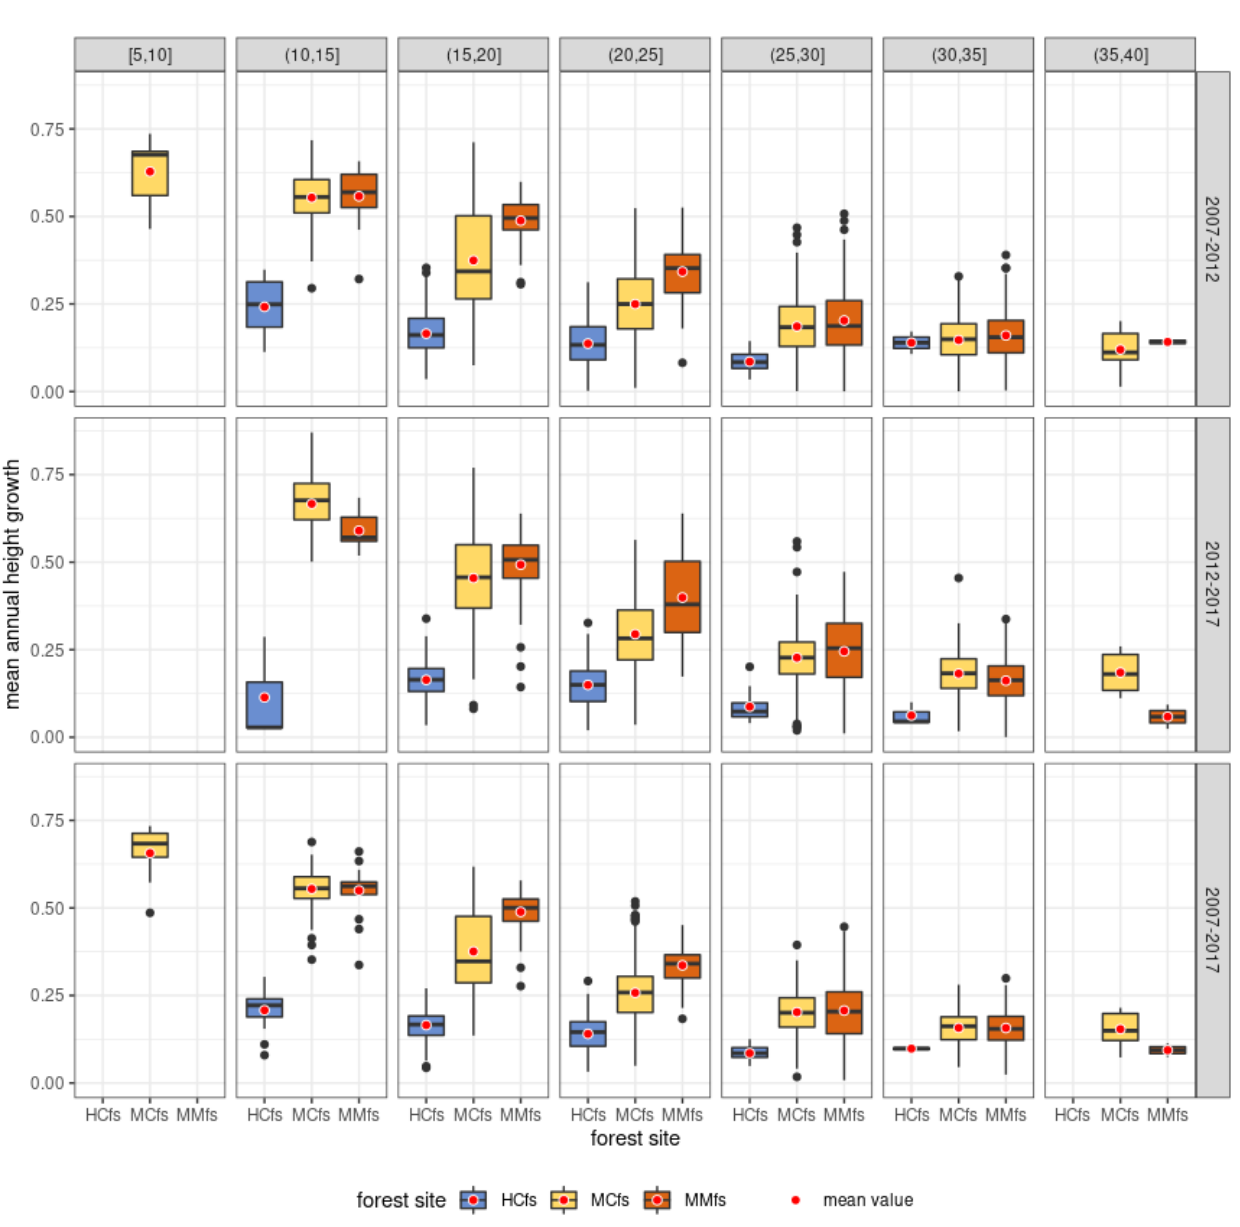
Figure 14. Distributions of mean annual height increments for Scots pine in the 2007–2012, 2012– 2017, and 2007–2017 height ranges with habitat